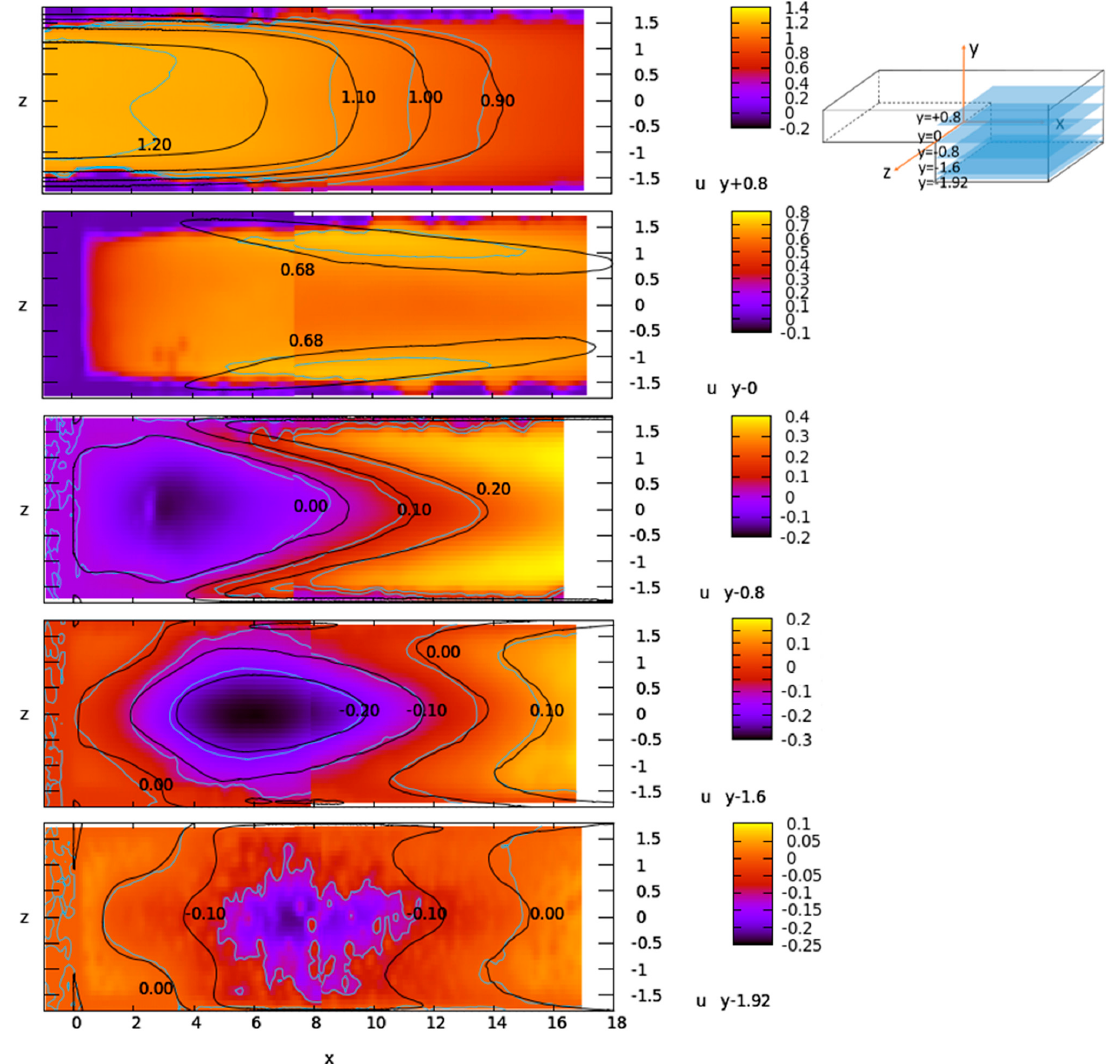
Figure 9. Time-averaged field of velocity component u in all y = const. planes. Measurements—color scale and blue contours. DNS—black contours.